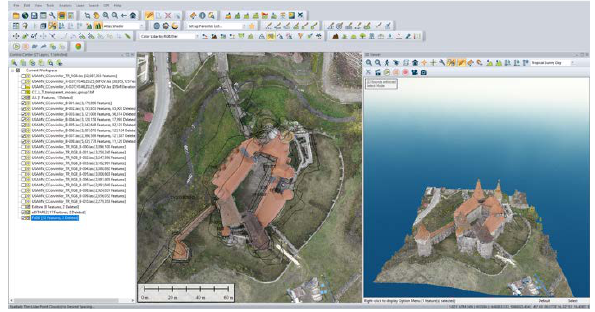
Figure 11. Corrections of LiDAR point clouds